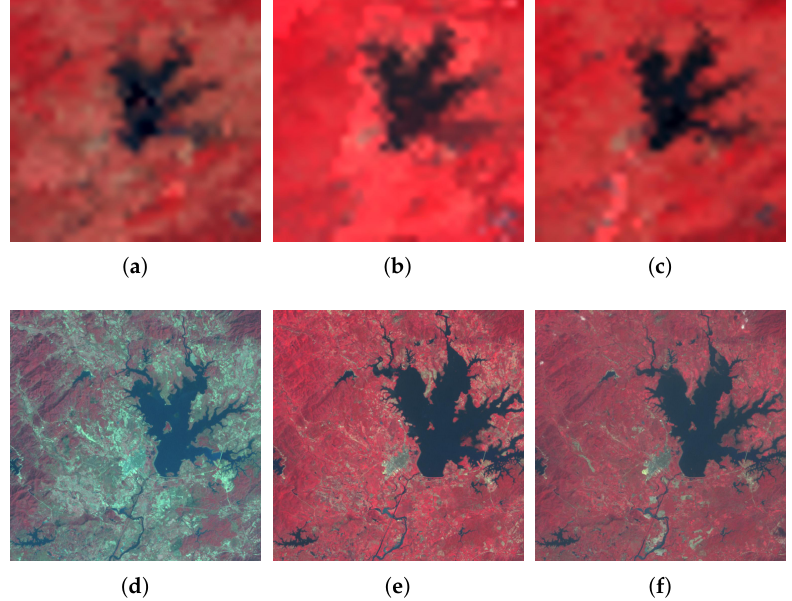
Figure 10. Remote sensing images with phenology changes: ( a ) MODIS on 11 February 2002; ( b ) MODIS on 29 August 2002; ( c ) MODIS on 15 October 2002; ( d ) Landsat on 17 February 2002; ( e ) Landsat on 29 August 2002; and ( f ) Landsat on 15 October